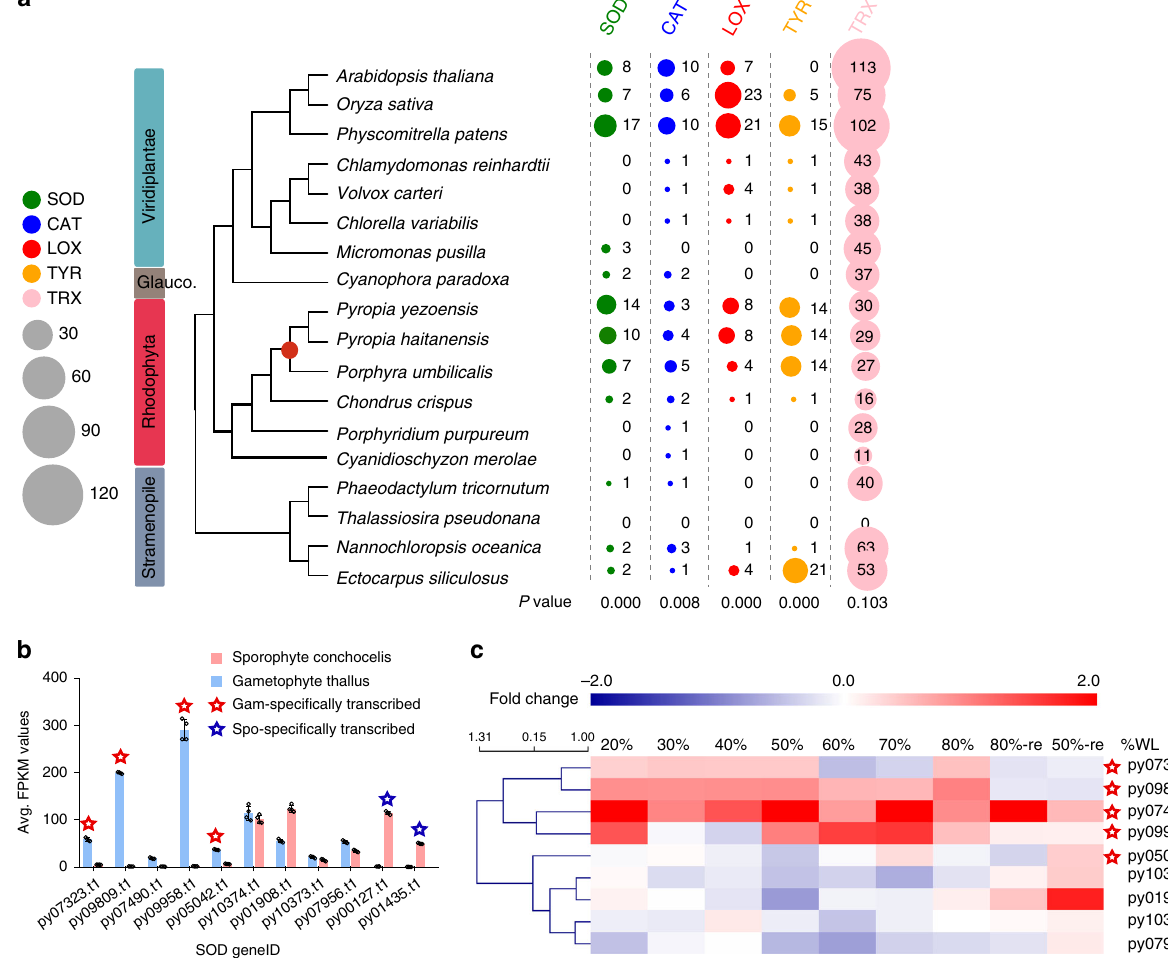
Fig. 2 The copy numbers of genes related to antioxidative functions and the transcriptional pattern of SOD genes. a Copy numbers of SOD, CAT, LOX, TYR, and TRX genes in algal genomes. The dendrogram was generated based on the phylogenetic tree constructed based on the 424 single-copy orthologous gene sets identi fi ed from P. yezoensis and the other 17 published algal genomes. The expanded orthogroups related to antioxidative functions are shown in different colors. The size of the circle represents gene copy number. P values are listed at the bottom of each column. b Transcriptional level of SOD paralogs in the two life phases. Columns and vertical bars represent the average FPKM values of SOD genes in individual life phase and SD (blue: gametophyte; red: sporophyte; n = 4 biological independent samples), respectively. Red and blue stars indicate the gam-speci fi cally transcribed and spo- speci fi cally transcribed genes, respectively. c Heatmap showing the fold change of SOD paralog transcripts in response to osmotic stress. Fold change was calculated as log 2 (FPKM( x % of water loss or rehydration)/FPKM (ctrl)). Percentages above the heatmap denote the degree of water loss and 80%-re and 50%-re denote the rehydrated samples after 80 and 50% of water loss, respectively. WL water